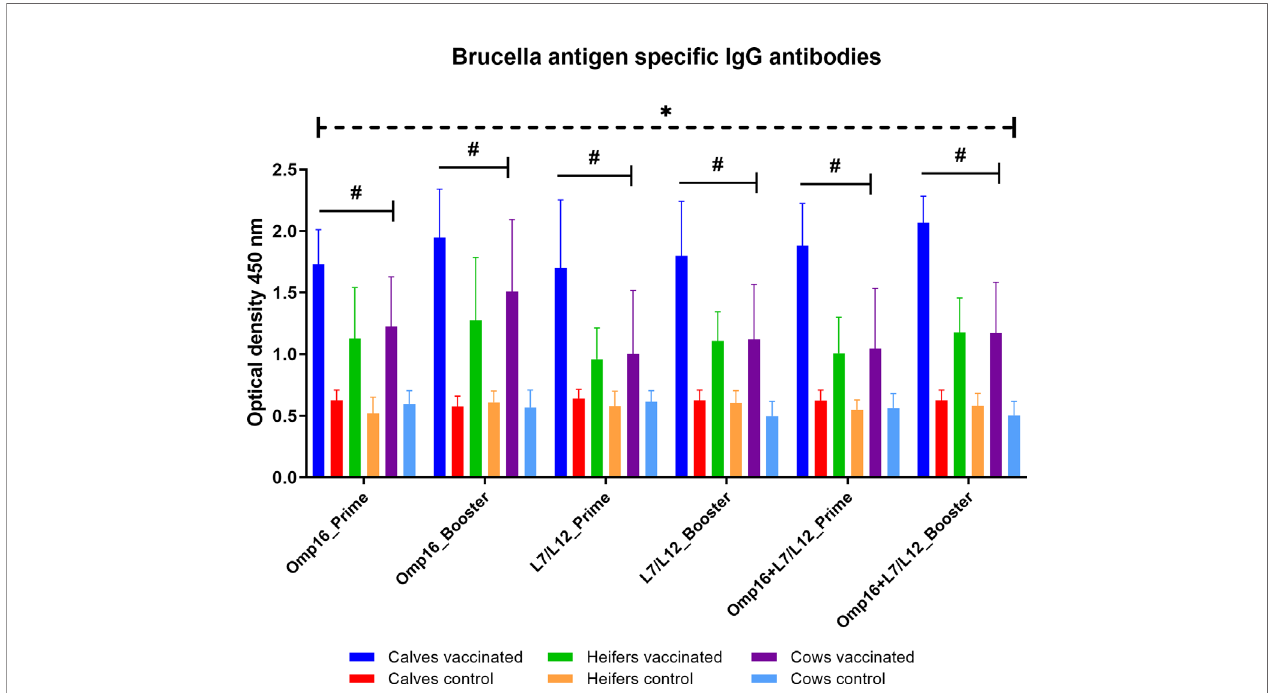
FIGURE 5 | IgG antibodies to individual Brucella Omp16 or L7/L12 proteins and to their mixtures by ELISA in calves, heifers and cows for 28 days after prime and booster vaccination. The calves, heifers, and adult cows in the vaccinated group were immunized twice via the subcutaneous route at an interval of 28 days with vaccines generated from the IVV subtypes H5N1 (prime vaccination) and H1N1 (booster vaccination). Animals in the control group were subcutaneously injected with 1.0 ml of 20% Montanide Gel01 adjuvant in PBS. The data was presented as means with standard errors (SEM). *P = 0.04 – P < 0.0001 vs. appropriate controls; # P = 0.01 – P < 0.0001 vs. heifers and cows. Statistical analysis was performed using two-way ANOVA followed by Tukey ’ s multiple comparisons test. P values < 0.05 were considered signi fi